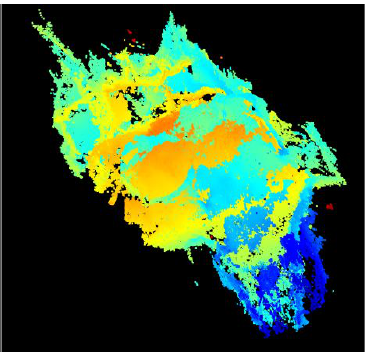
Figure 3. The finalized product of the merged point clouds of the cave in Unity. Figure 2. Top down view of the Cave’s merged point cloud made from two existing point clouds, respectively the rear view and front view of the pictures. This is shown using lidarview.com. 3-D Models were made from the two flight paths. Point cloud models were then extracted from the models and merged into one single point cloud. The resulting point cloud is illustrated in Figure 2. From the 500 pictures that were taken, 450